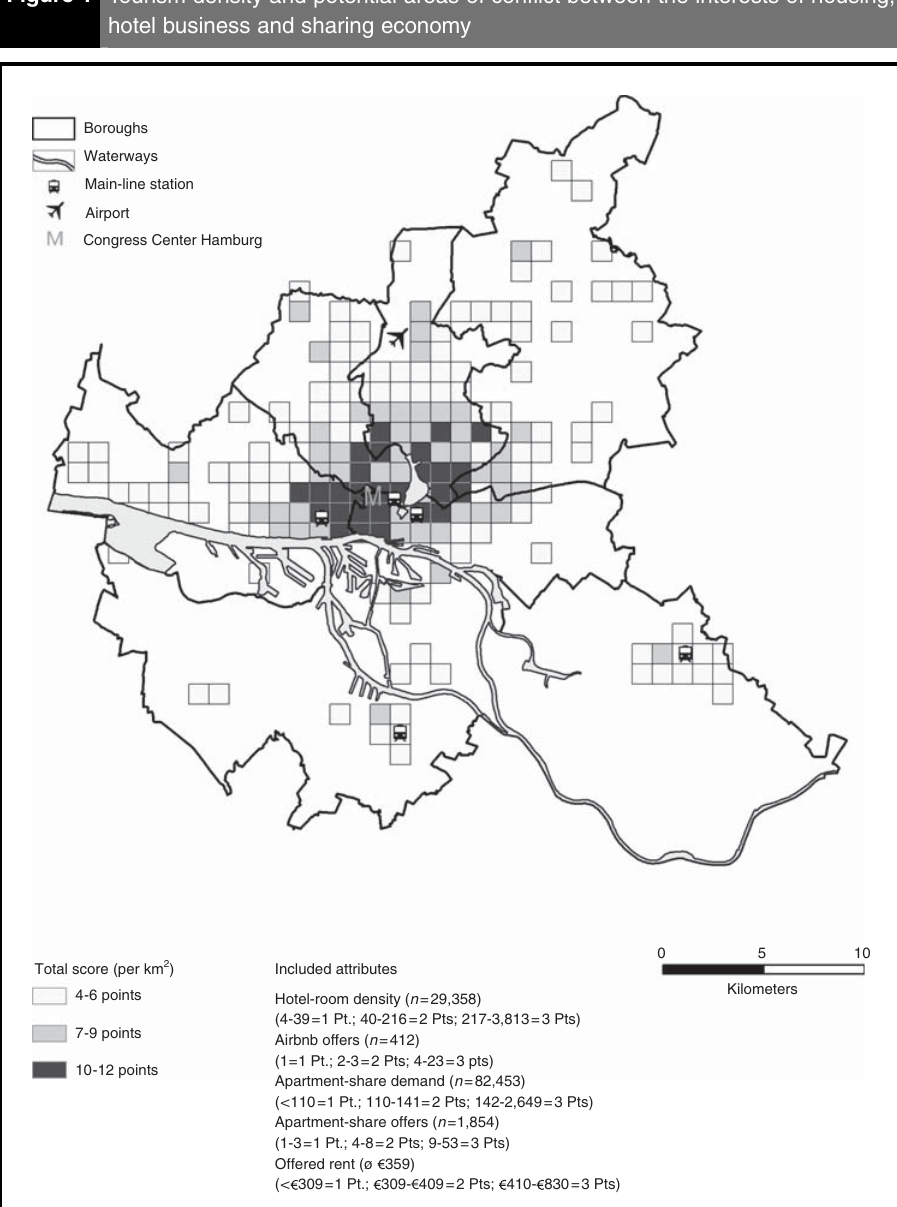
Figure 1 Tourism density and potential areas of conflict between the interests of housing, hotel business and sharing